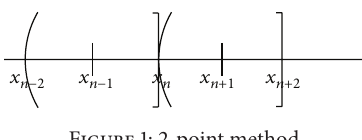
Figure 1: 2-point